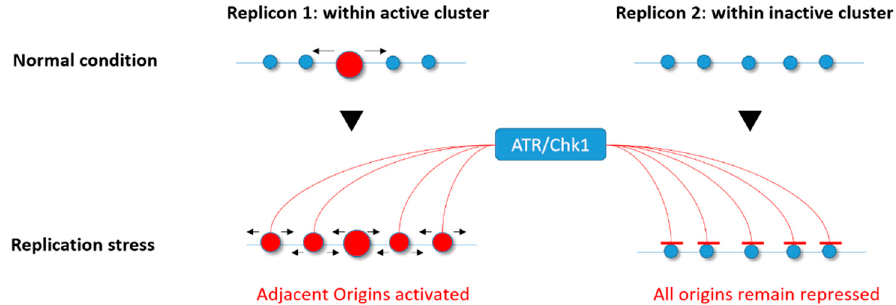
Figure 3. Ataxia telangiectasia Rad3-related (ATR)/checkpoint kinase 1 (Chk1) involvement in the differential regulation of origin firing under replicative stress. In response to replication stress, the ATR/Chk1 kinases allow the activation of dormant origins within active replicon clusters (active origin(s) in red) while repressing any firing within those that are not yet activated (inactive origins in blue).